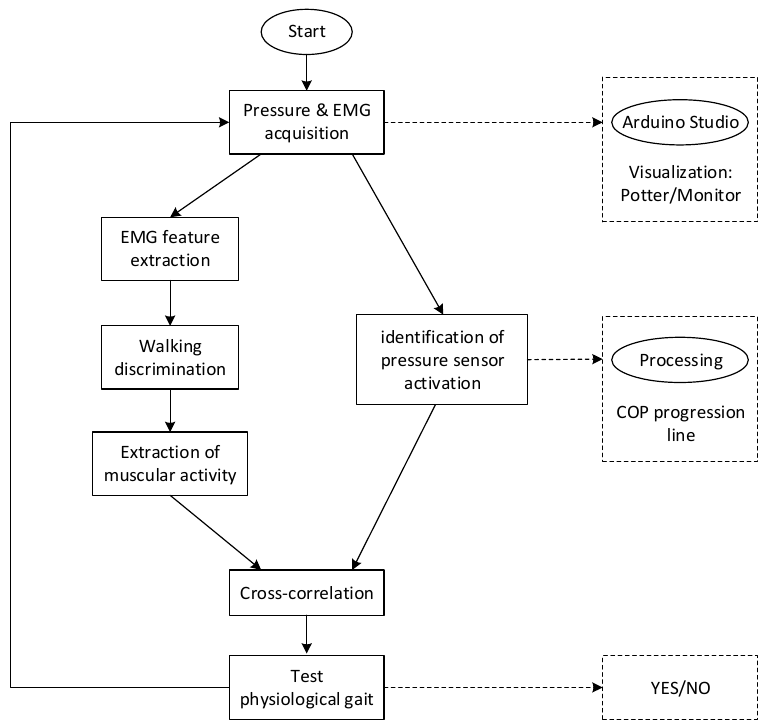
Figure 8. Logical diagram of the wearable foot biomechanics monitoring system software.